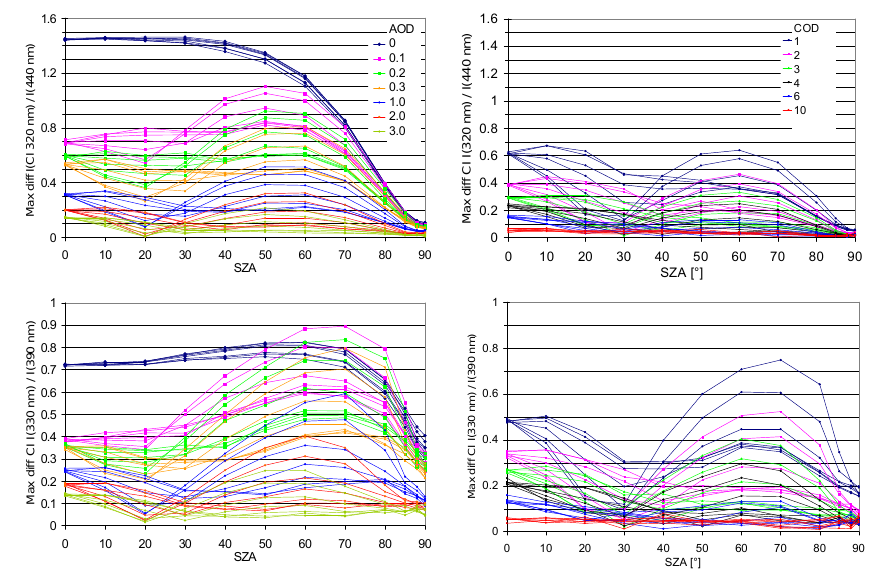
Figure A2. Same results as in Fig. 12, but for zenith observations at exactly 90 ◦ elevation.